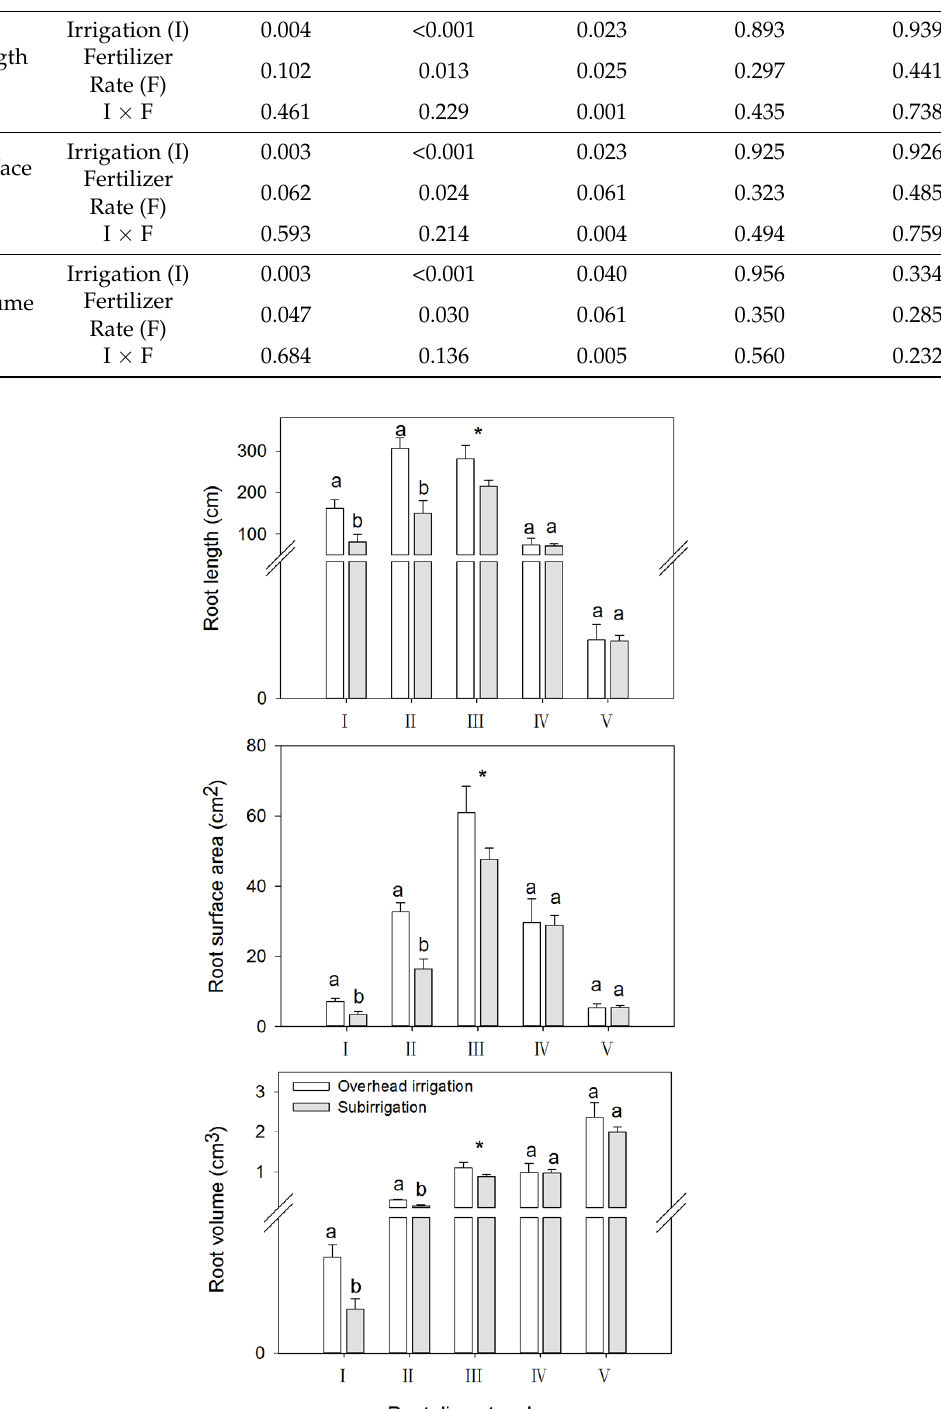
Table 3. p -values for main effect of fertilizer rate and irrigation and their interaction on root length surface area and volume of different class.